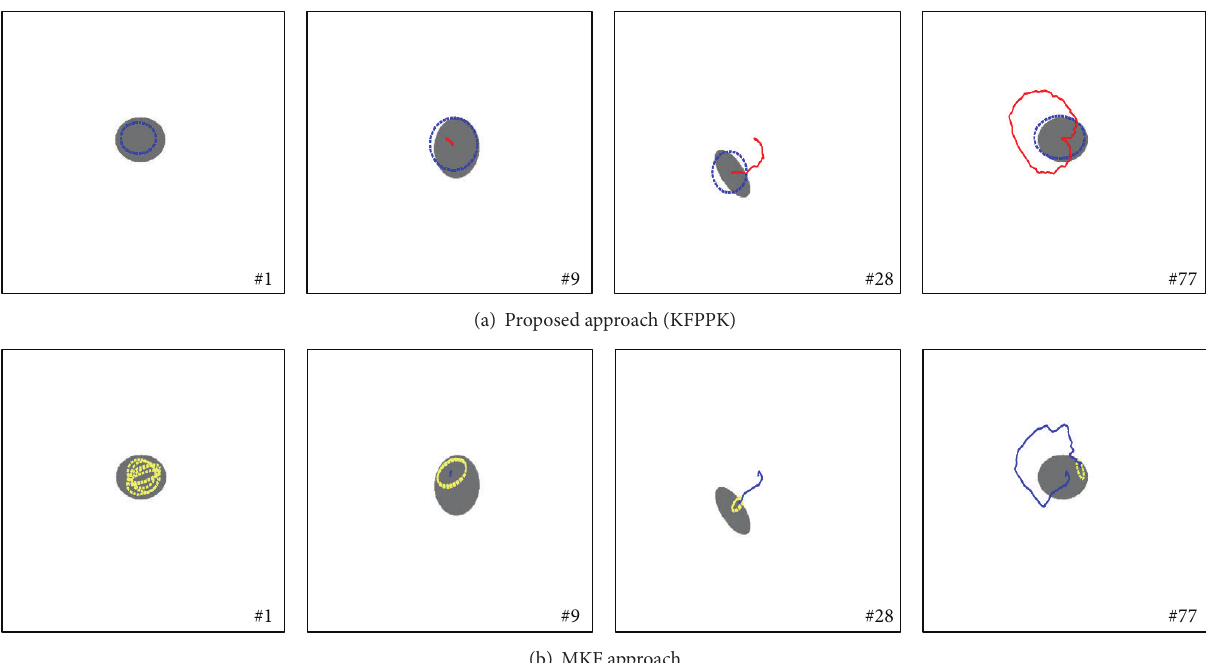
Figure 2: Tracking results of the synthetic ellipse sequence by different tracking algorithms. Frames 1, 9, 28, and 77 are displayed.